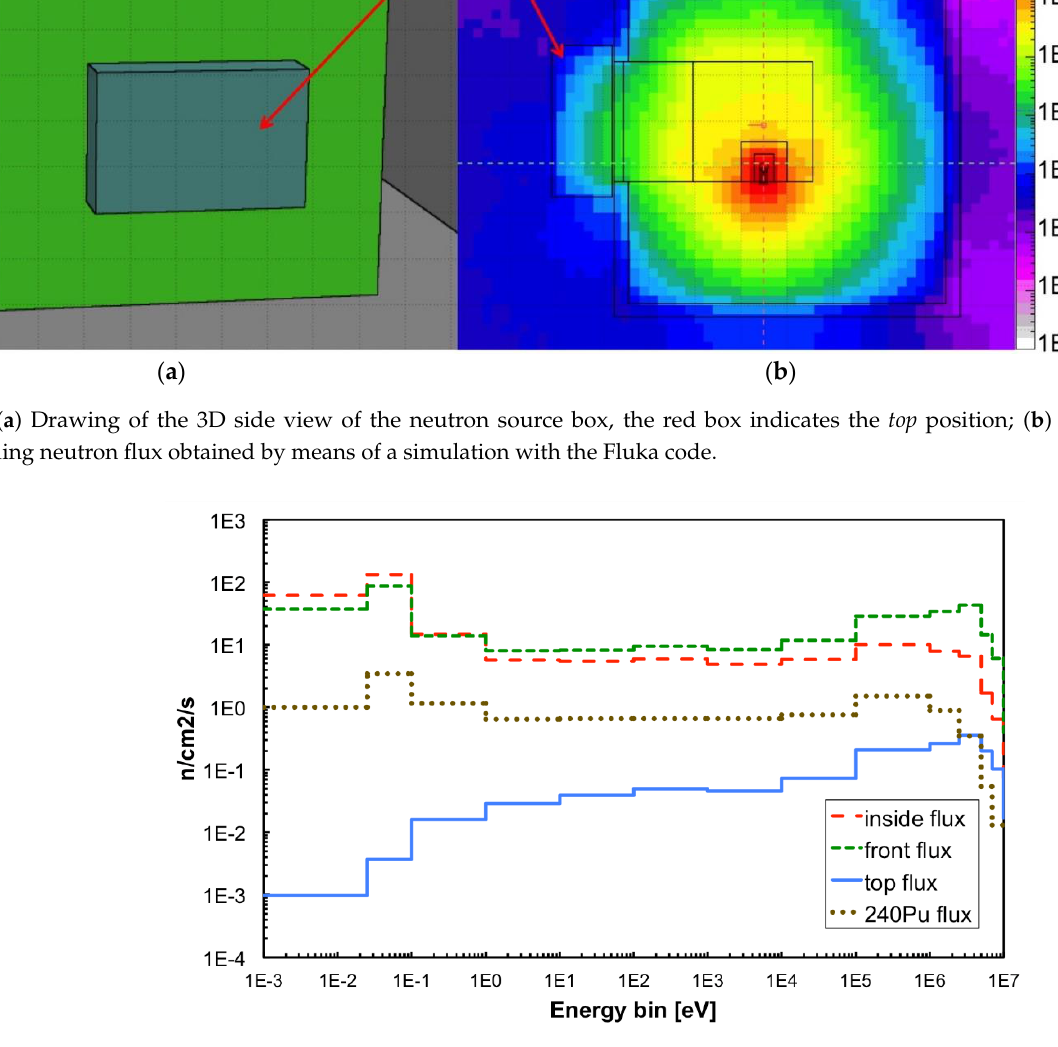
Figure 9. Neutron flux simulated in the three measurement positions with Fluka, and with MCNP on the detectors in the radwaste package exercise with 240 Pu (see the Discussion section).